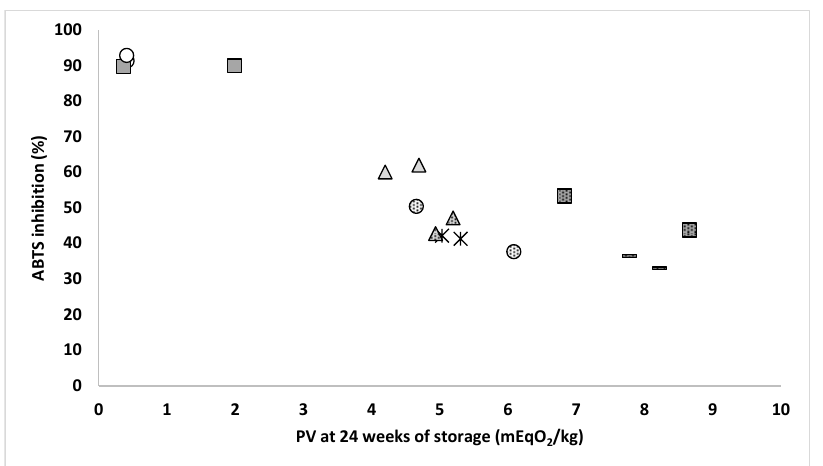
Figure 5. Correlation between the oxidative state (PV) of the different fats from BSFL after 24 weeks of storage time and the initial antioxidant activity (ABST inhibition) of the fat samples. Undotted circles (freezing, freeze-drying, mechanical pressing), dotted circles (freezing, freeze-drying, SFE), undotted triangles (freezing, oven-drying, mechanical pressing), dotted triangles (freezing, oven-drying, SFE), undotted squares (blanching, freeze-drying, mechanical pressing), dotted squares (blanching, freeze-drying, SFE), asterisks (blanching, oven-drying, mechanical pressing), line (blanching, oven-drying, SFE).